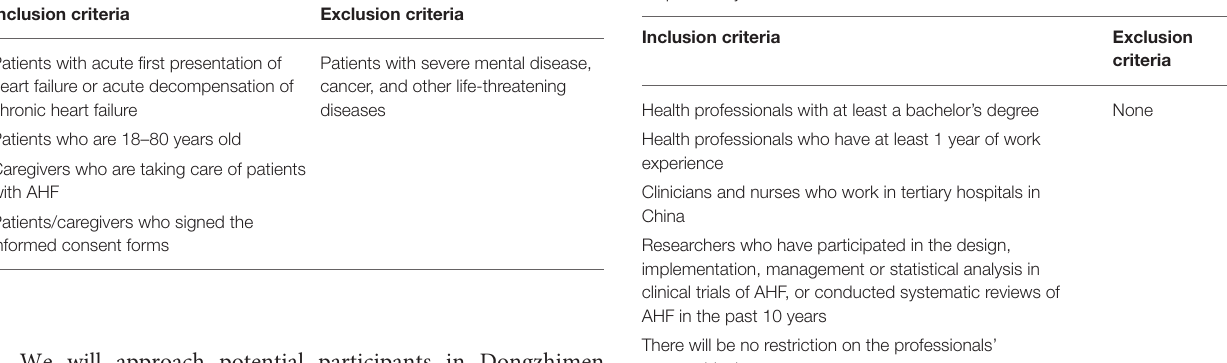
TABLE 4 | The inclusion and exclusion criteria for health professionals in the Delphi survey. Inclusion